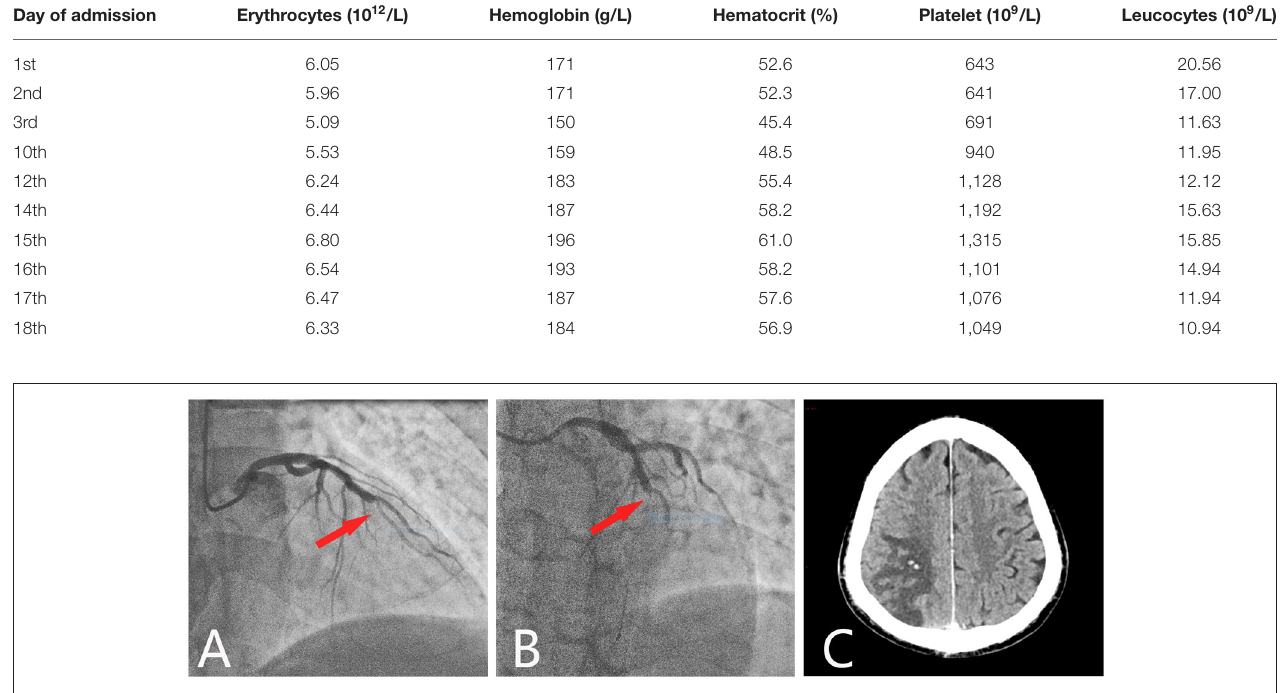
FIGURE 1 | Coronary angiography and cerebral CT. Coronary angiography showed a total occlusion at the mid-left anterior descending branch (red arrow). (A) Cranial view. (B) Left cranial view. (C) Axial cerebral CT showed hypodensity in the right parietooccipital lobe, with two spotted hyperdense areas.